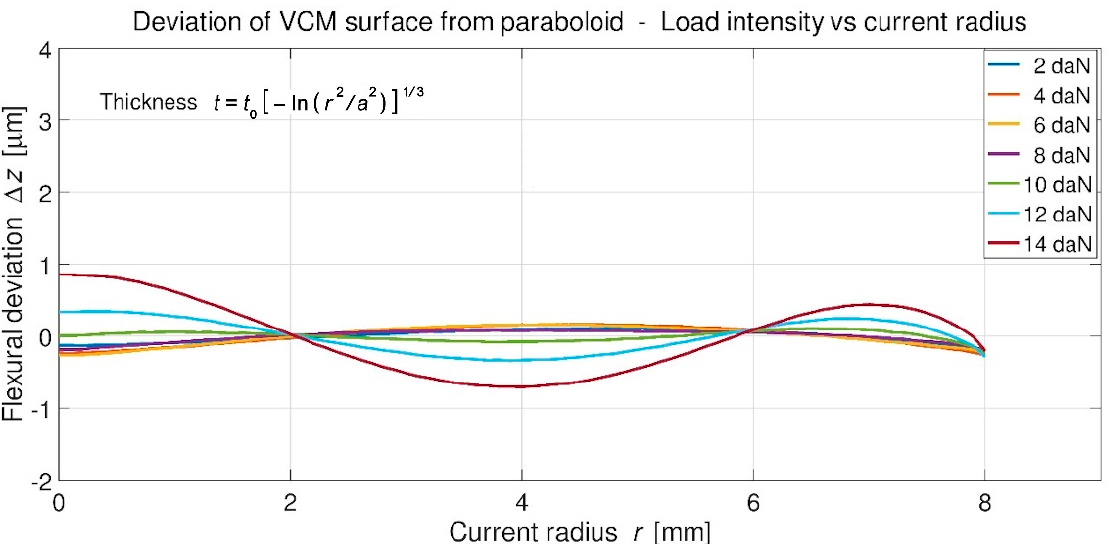
Figure 6. Least mean-square flexural deviations with truncated radius at ρ = 0.05 and stud thickness t c = 618 μ m. Thickness T = t / t 0 = [ − ln( ρ 2 )] 1/3 for 0.05 < ρ < 0.95 and t 0 = 300 μ m. Conical for ρ > 0.95 with t (1) = 100 μ m.